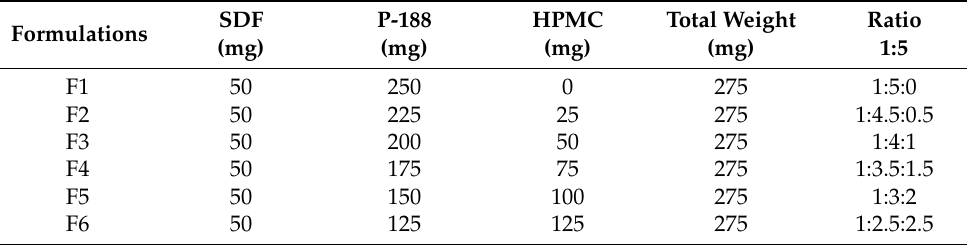
Table 4. Controlled release polymer matrices containing various drug to polymer ratios.